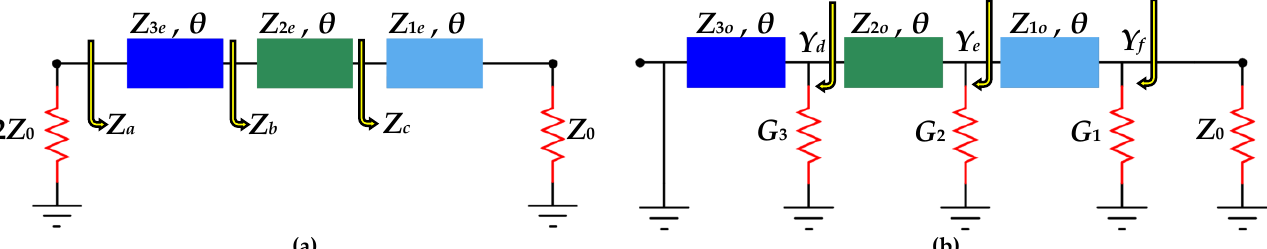
Figure 3. ( a ) The even-mode equivalent circuit, ( b ). The odd-mode equivalent circuit.